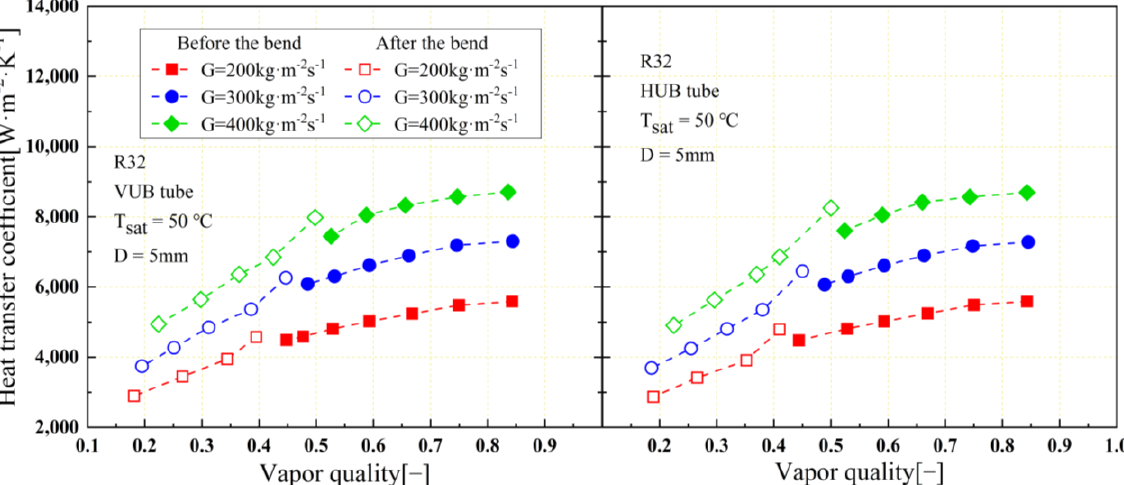
Figure 14. Predicted average heat transfer coefficient over VUB tube and HUB tube with varied vapor qualities.